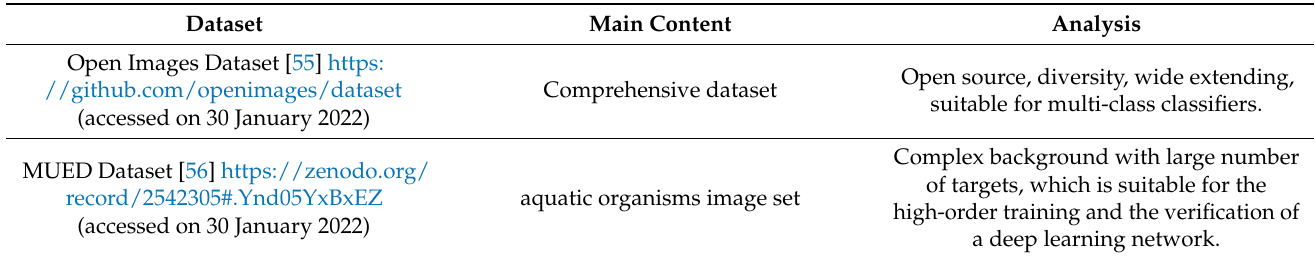
Table 4. Dataset